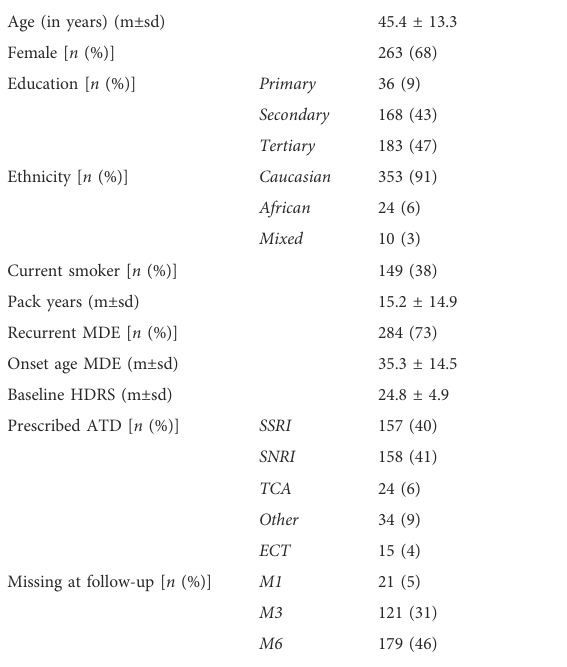
TABLE 1 Sociodemographic characteristics. Sociodemographic characteristics of METADAP patients are shown for the whole sample. Kruskal – Wallis tests were used to compare age, tobacco consumption, onset age of MDE, and baseline HDRS scores (presented as mean ± standard deviation (m±sd)). Fisher Exact testswereusedtocomparesex,socio-educationstatus,ethnicity, smoking statusatbaseline,MDErecurrence,prescribedATDdrug, and dropout rates across study time (presented as the number of patients and percentage). *: p < 0.05; **: p < 0.01; ***: p < 0.001. ATD, antidepressant drug; ECT, electroconvulsive therapy; HDRS, 17-item Hamilton Depression Rating Scale; m, mean; M1, after 1 month of treatment; M3, after 3 months of treatment; M6, after 6 months of treatment; MDE, major depressive episode; n, number of patients; p : p -value; SNRI, serotonin norepinephrine reuptake inhibitor; sd, standard deviation; SSRI, selective serotonin reuptake inhibitor; TCA, tricyclic